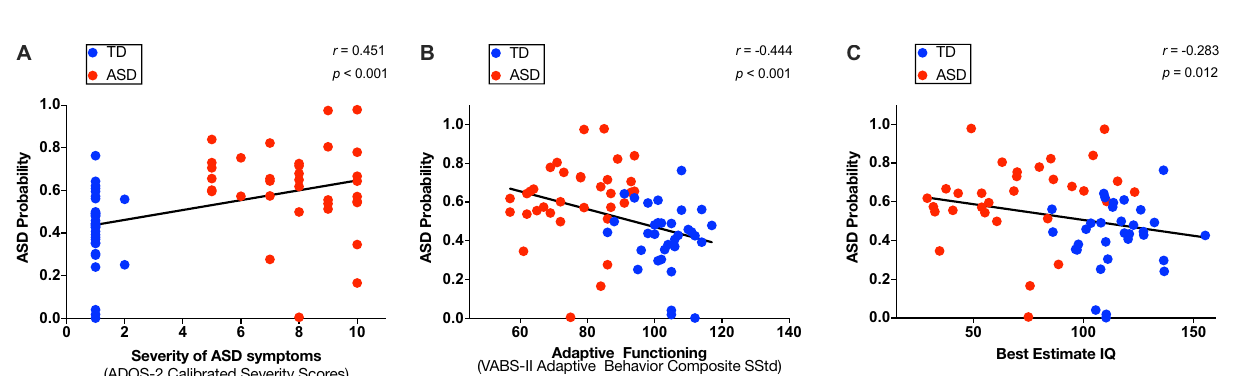
Figure 4. Scatter plots depicting the relation between predicted ASD probability and clinical measures: ( A ) Total level of severity of autistic symptoms, ( B ). Adaptive functioning, ( C ). Best estimate Intellectual Quotient. The least squares linear fit is depicted as black line and values of Spearman r coefficient and corresponding p values are shown on each panel. Ground-truth classes: ASD = red, TD =